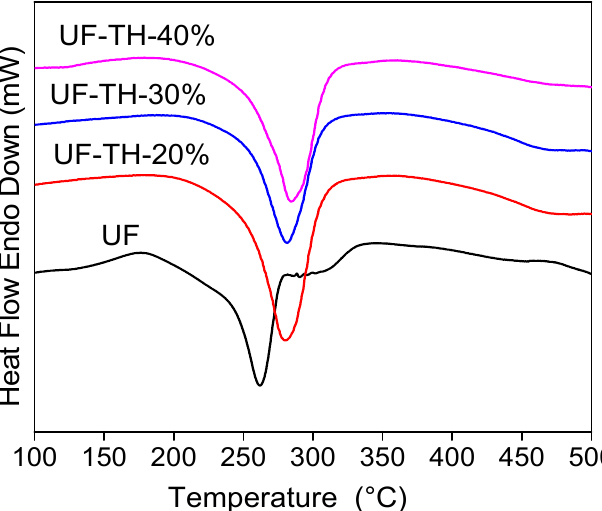
Figure 5. DTA curves of UF and UF/HNTs nanocomposite.